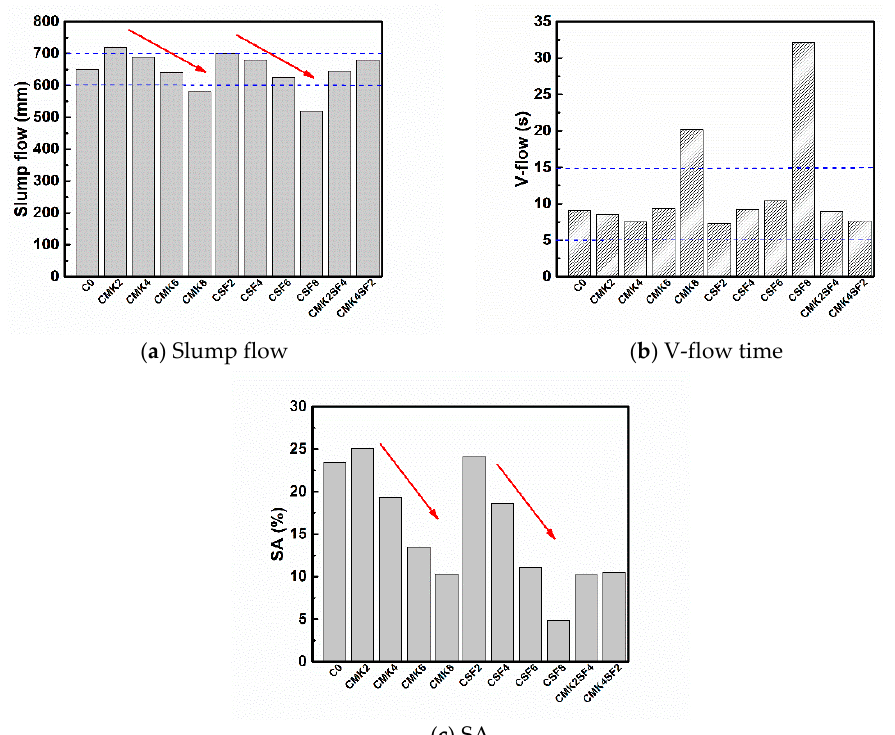
Figure 6. Effect of MK and SF on the workability of self-compacting concrete (SCC) (The red arrows indicate the change of SCC performance with the increase of MK and SF contents).